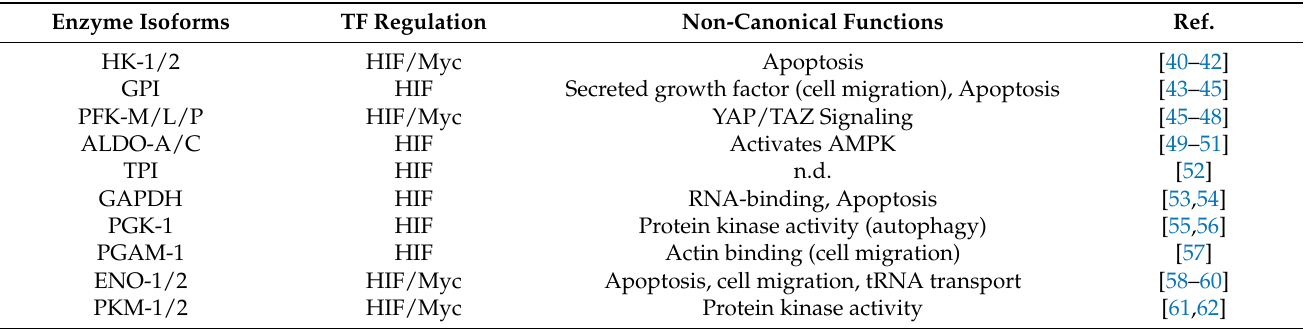
Table 1. Non-canonical functions of glycolytic